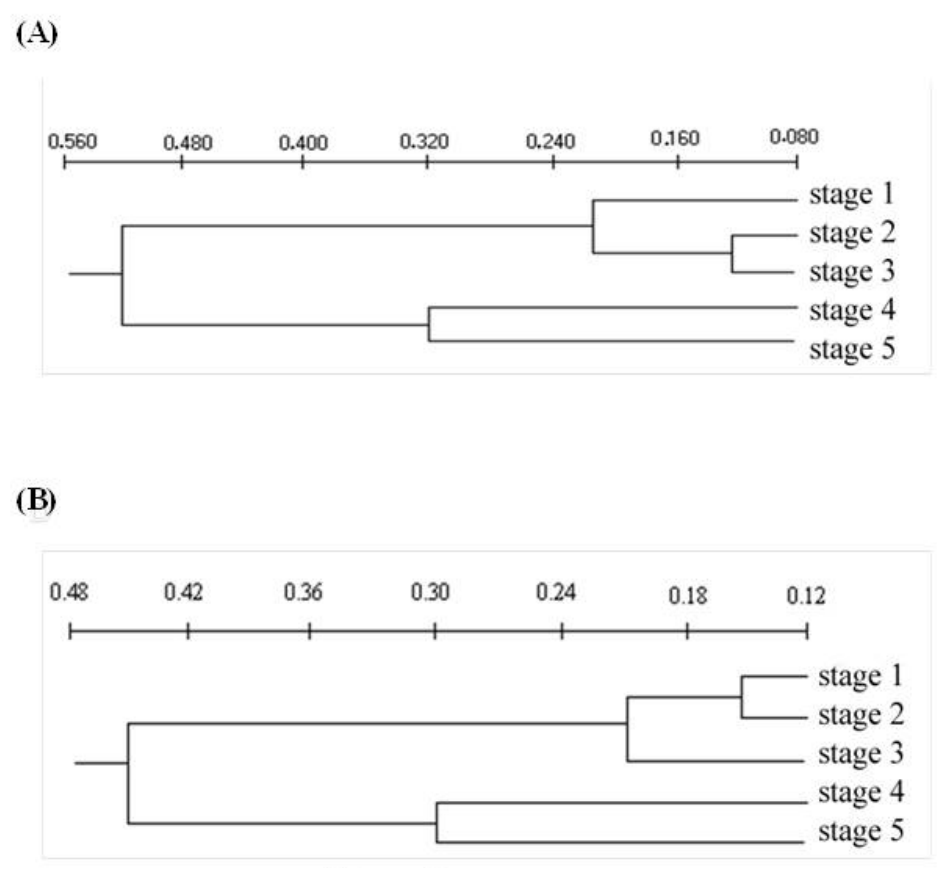
Figure 3. Cluster analysis of the quantitative anatomical variables for the five leaf development stages of Eucalyptus grandis . ( A ) Young (6 months old) and ( B ) mature (20 months old) plants.